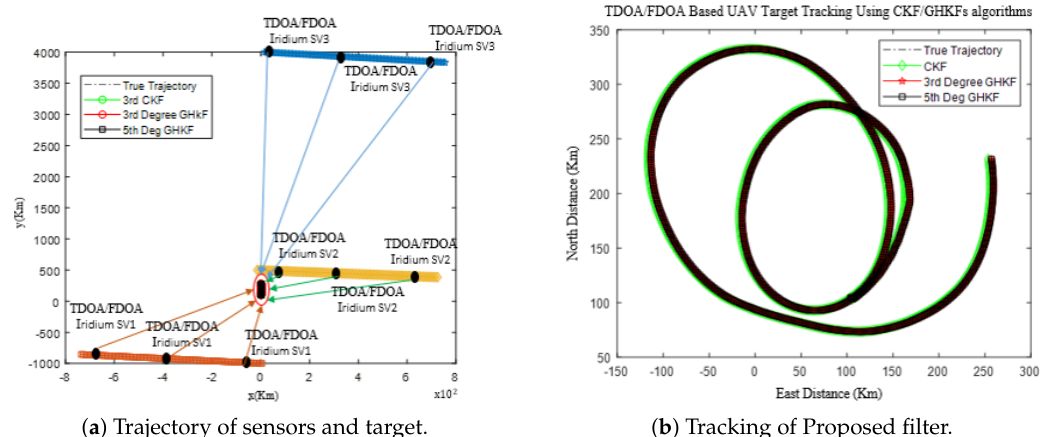
Figure 31. Three (03) Iridium satellites were employed to track a UAV based on a TDOA/FDOA measurement. Authors’ own elaboration.